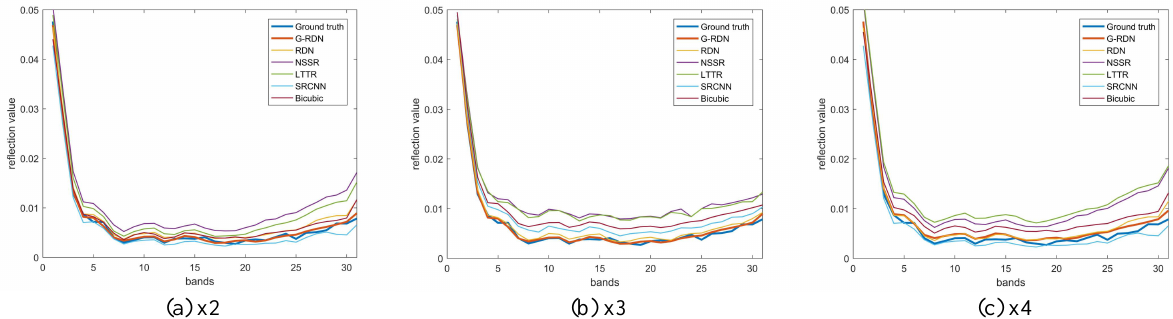
Figure 8. Visual exhibition of the spectral curves of a randomly selected pixel in the reconstructed test HSIs.